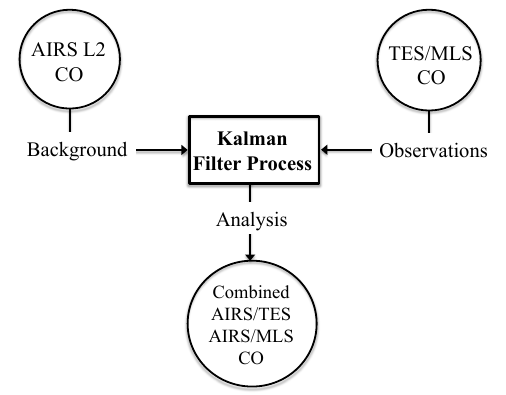
Fig. 1. Design of the satellite data fusion system, where AIRS operational V5 L2 retrievals are used as the background field, and TES or MLS measurements are added to the Kalman filter process as observations.